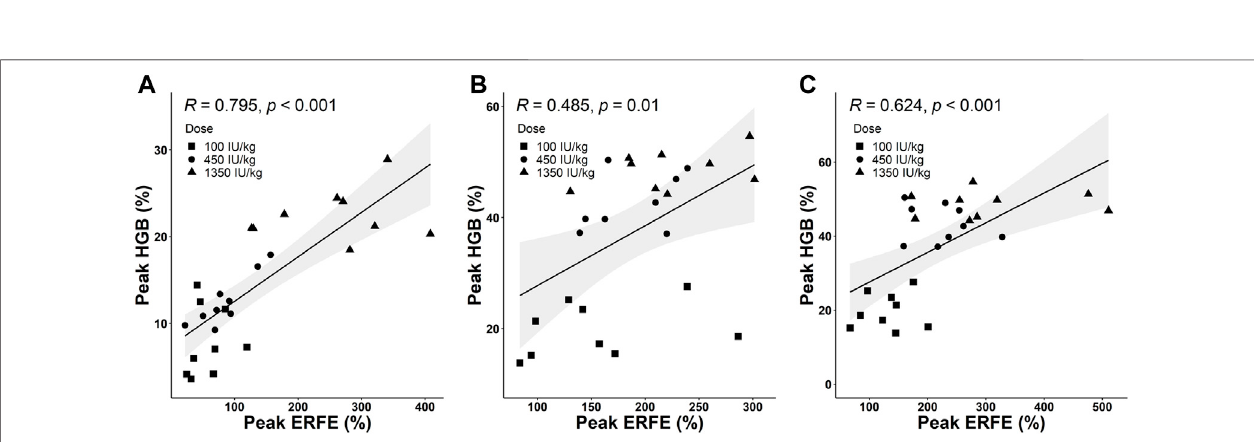
FIGURE6|(A) ThecorrelationbetweenpeakvaluesofnormalizedERFEandHGBresponse inthesingle-dose study. (B,C) Thecorrelationsbetweenpeakvalues of normalized ERFE and HGB response after the fi rst dose (B) and sixth dose (C) in the multiple-dose study (Pearson ’ s method; R is the correlation coef fi cient). The shaded area is the 95% con fi dence